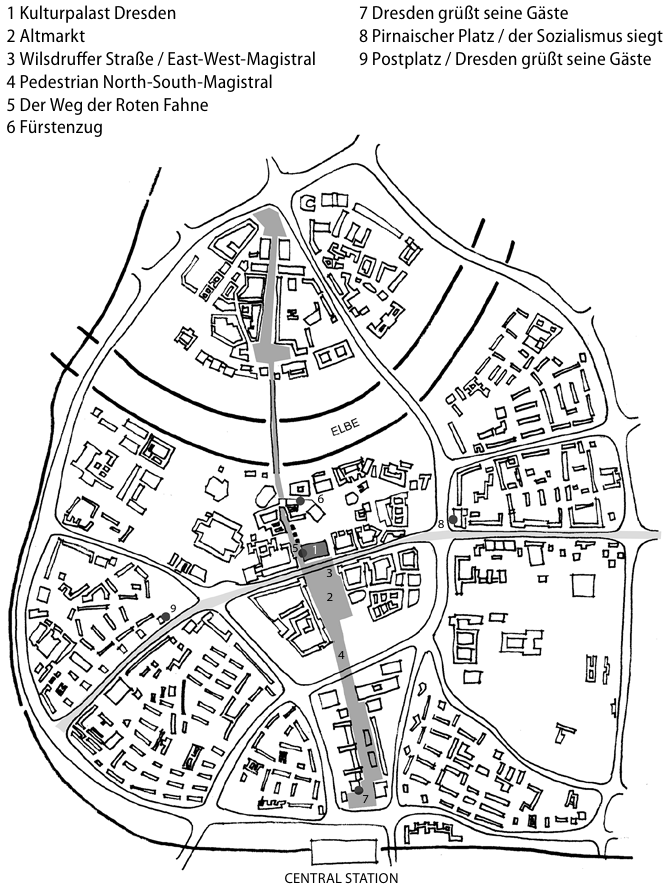
fig. 6. Sketch Concept of Pedestrian Axis in the 1960ies.